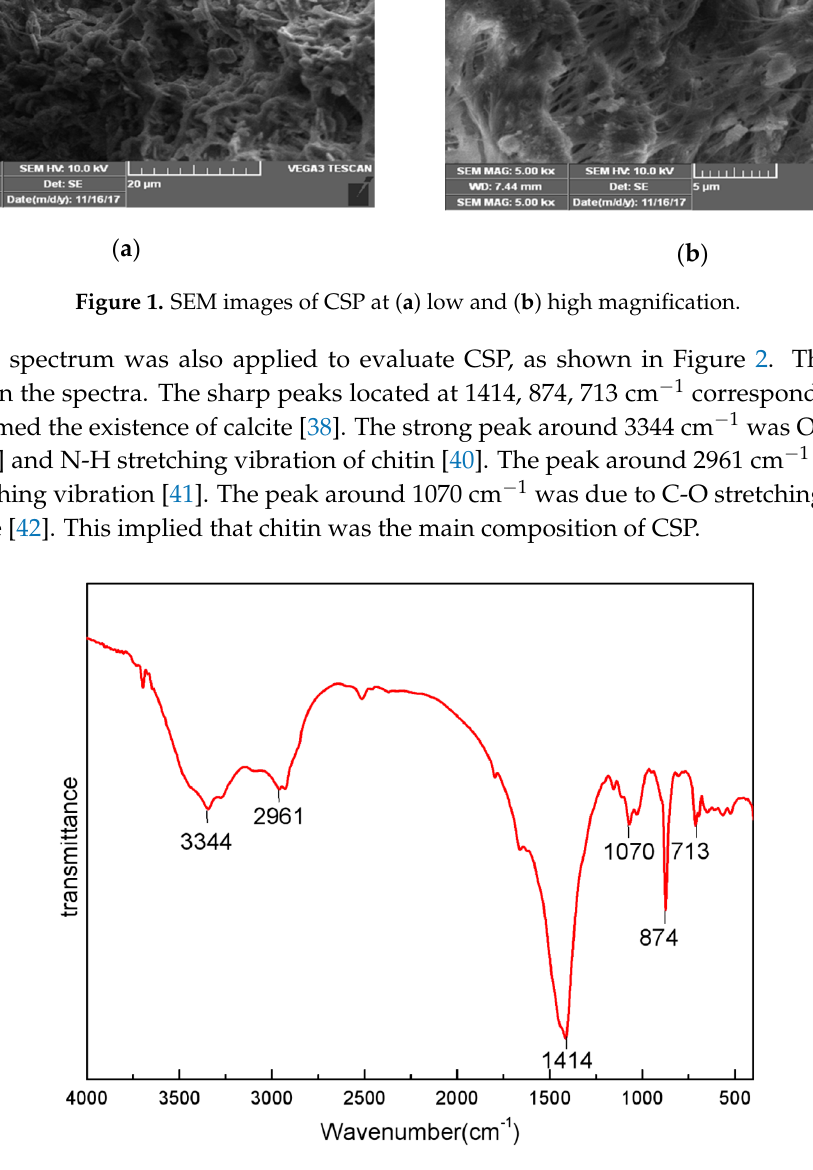
Figure 2. FT-IR spectrum for CSP.